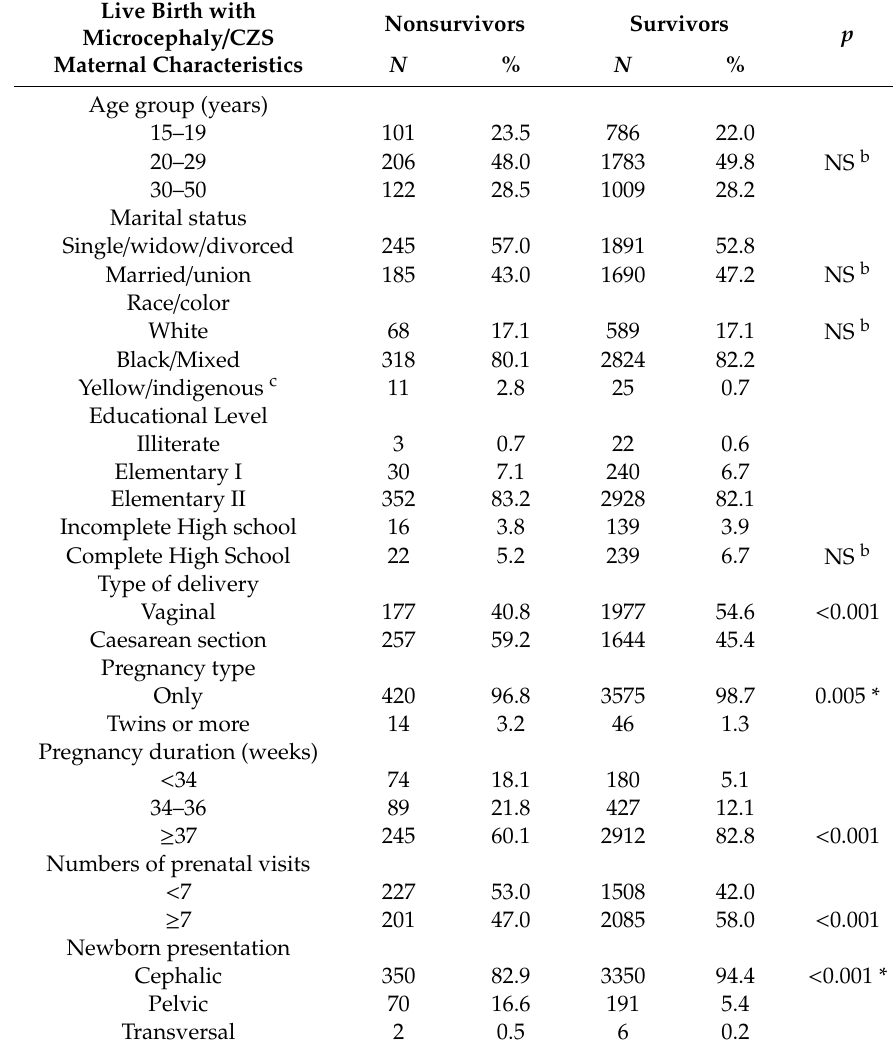
Table 3. Number and percentage of live birth with microcephaly / congenital Zika syndrome (confirmed and possible a ) who died and who did not die according to maternal sociodemographic and health care characteristics. Brazil.